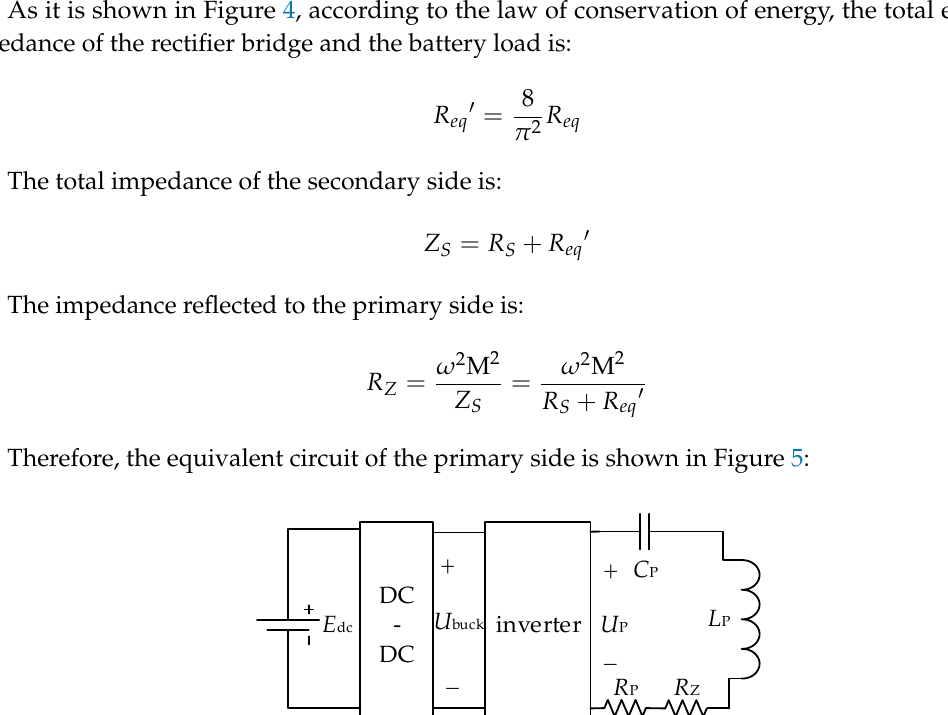
Figure 4. Simplified equivalent circuit of secondary side.